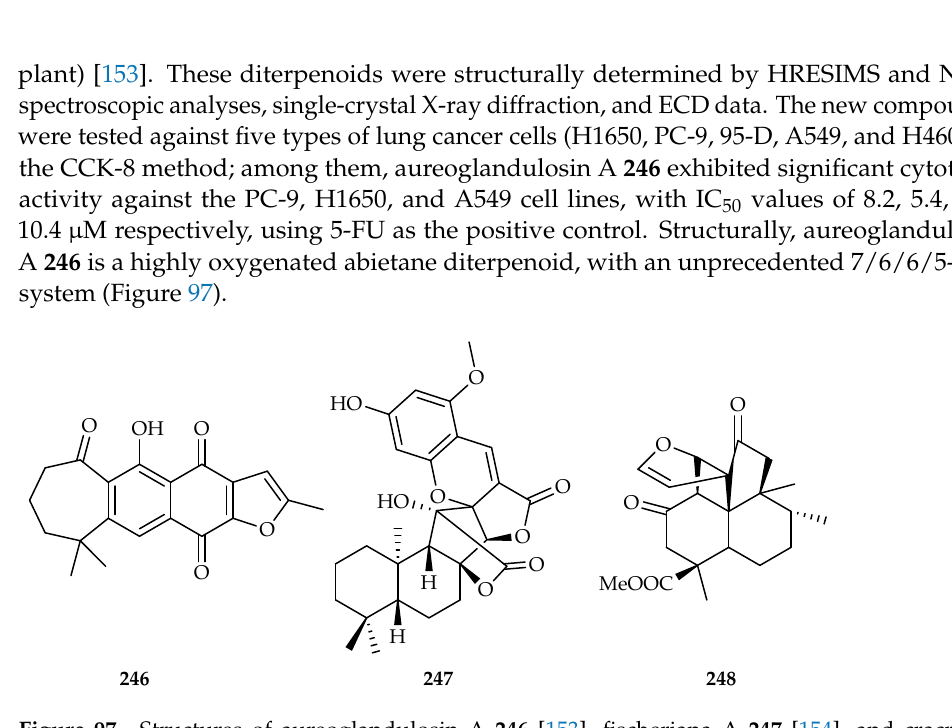
Figure 97. Structures of aureoglandulosin A 246 [153], fischeriana A 247 [154], and cracroson D 248 [43]. D 248